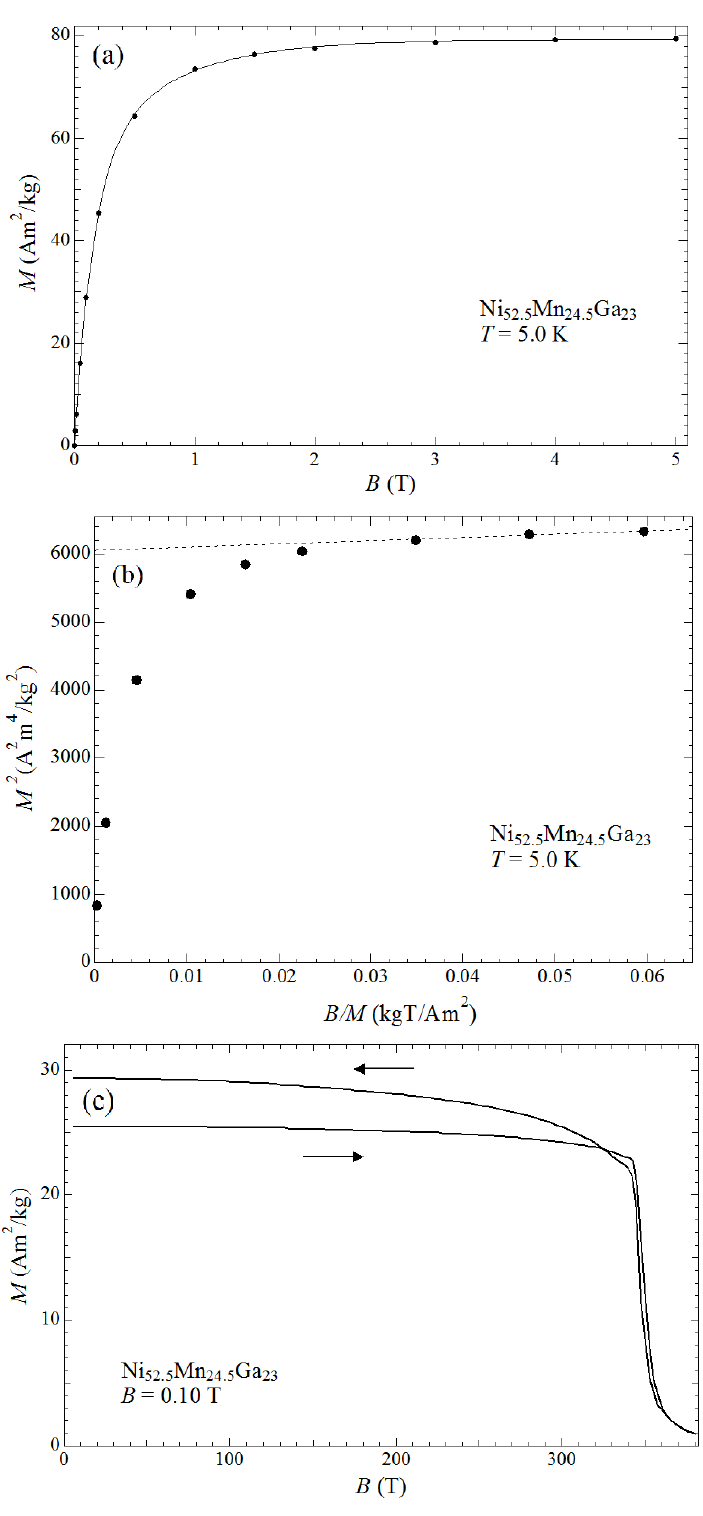
Figure 5. ( a ) Magnetization of Ni magnetization at 5 K; ( c ) temperature dependence of magnetization at 0.10